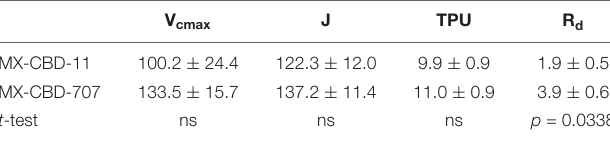
TABLE 5 | Maximum carboxylation rate of Rubisco (V cmax ), maximum rate of electron transport (J), maximum rate of triose phosphate utilization (TPU), and day respiration (R d ) of two breeding populations of medical cannabis MX-CBD-11 and MX-CBD-707.